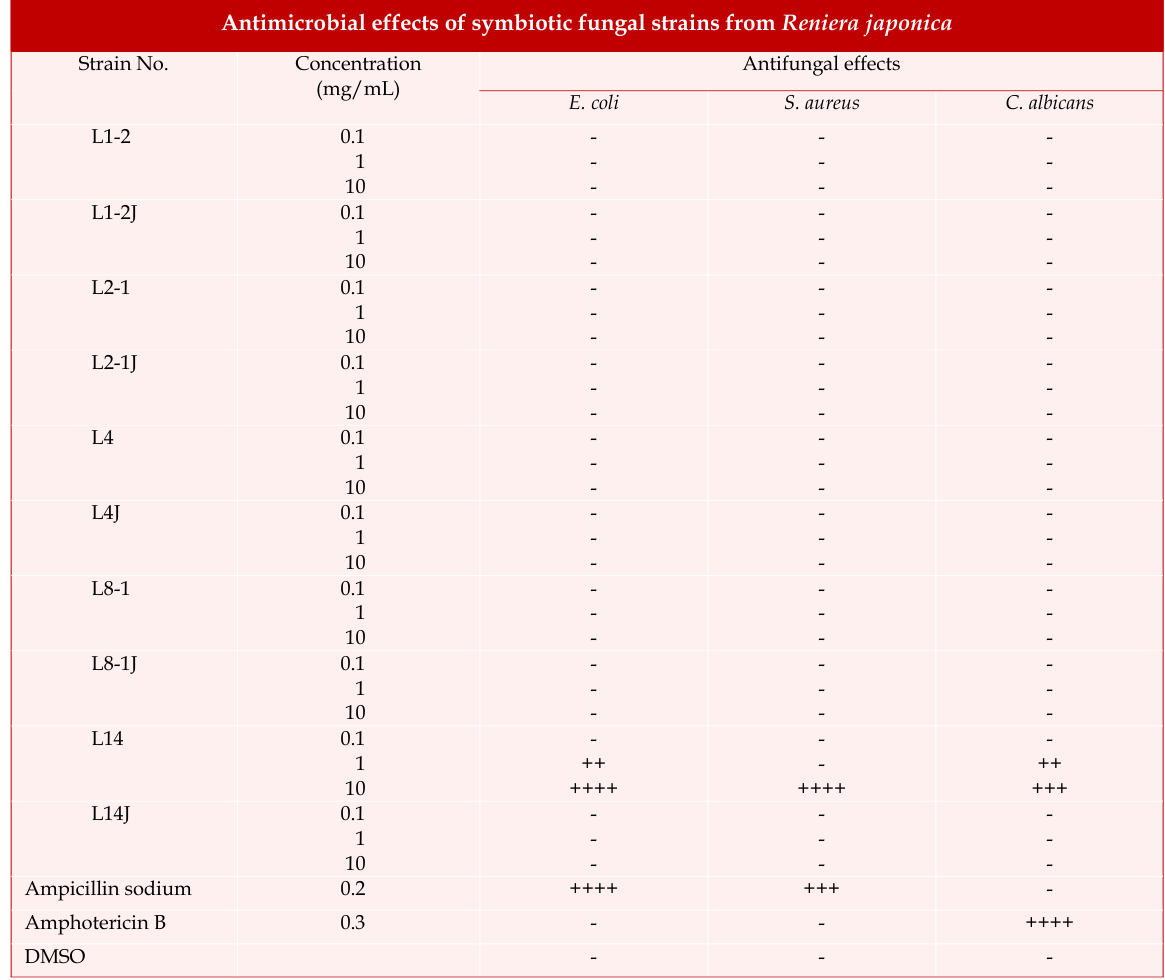
Antimicrobial effects of symbiotic fungal strains from Reniera japonica Strain